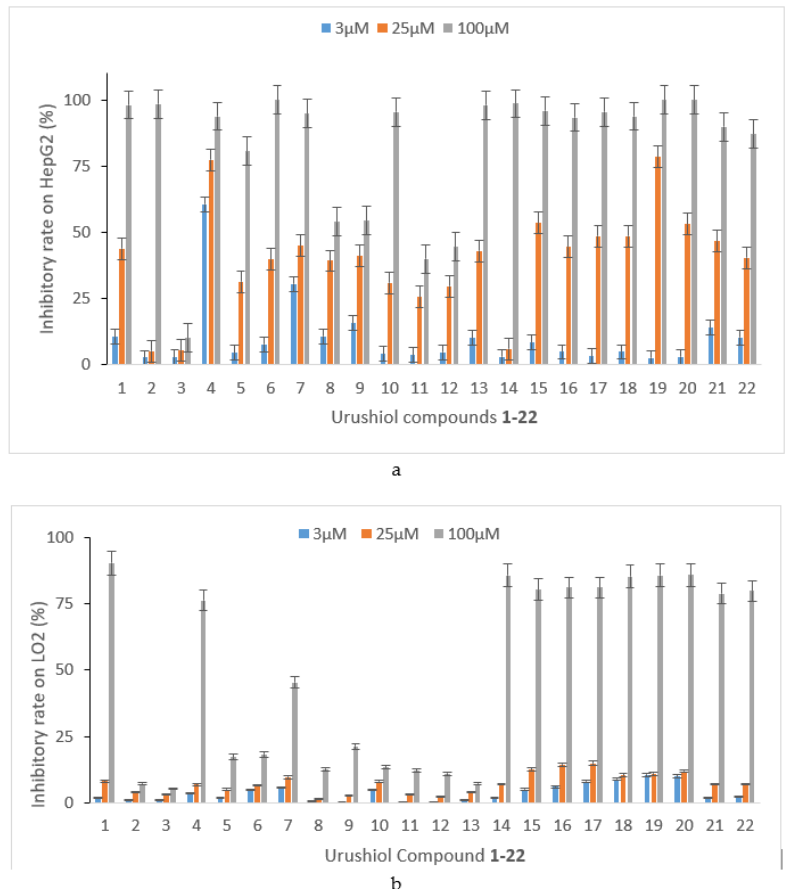
Figure 1. Urushiol compounds’ ( 1 – 22 ) inhibitory effect on ( a ) human liver hepatocellular carcinoma (HepG2) and ( b ) liver normal hepatocellular (LO2) cell proliferation. Three groups were very different from each other ( p < 0.05) (details show in supplementary materials). ( a ) The inhibitory effect of compounds 1 – 22 on the HepG2 cell proliferation; and ( b ) the inhibitory (toxicity) effect of compounds 1 – 22 on the LO2 cell proliferation.